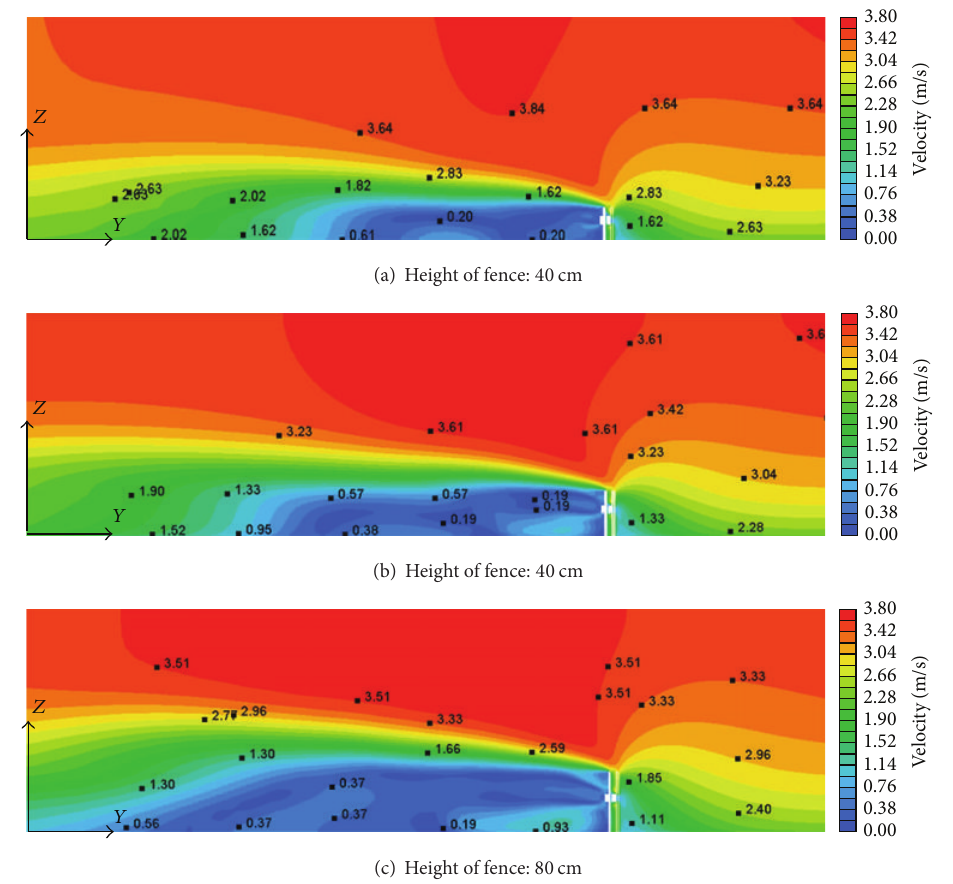
Figure 9: Wind velocity flow the double windbreak fence by height (velocity